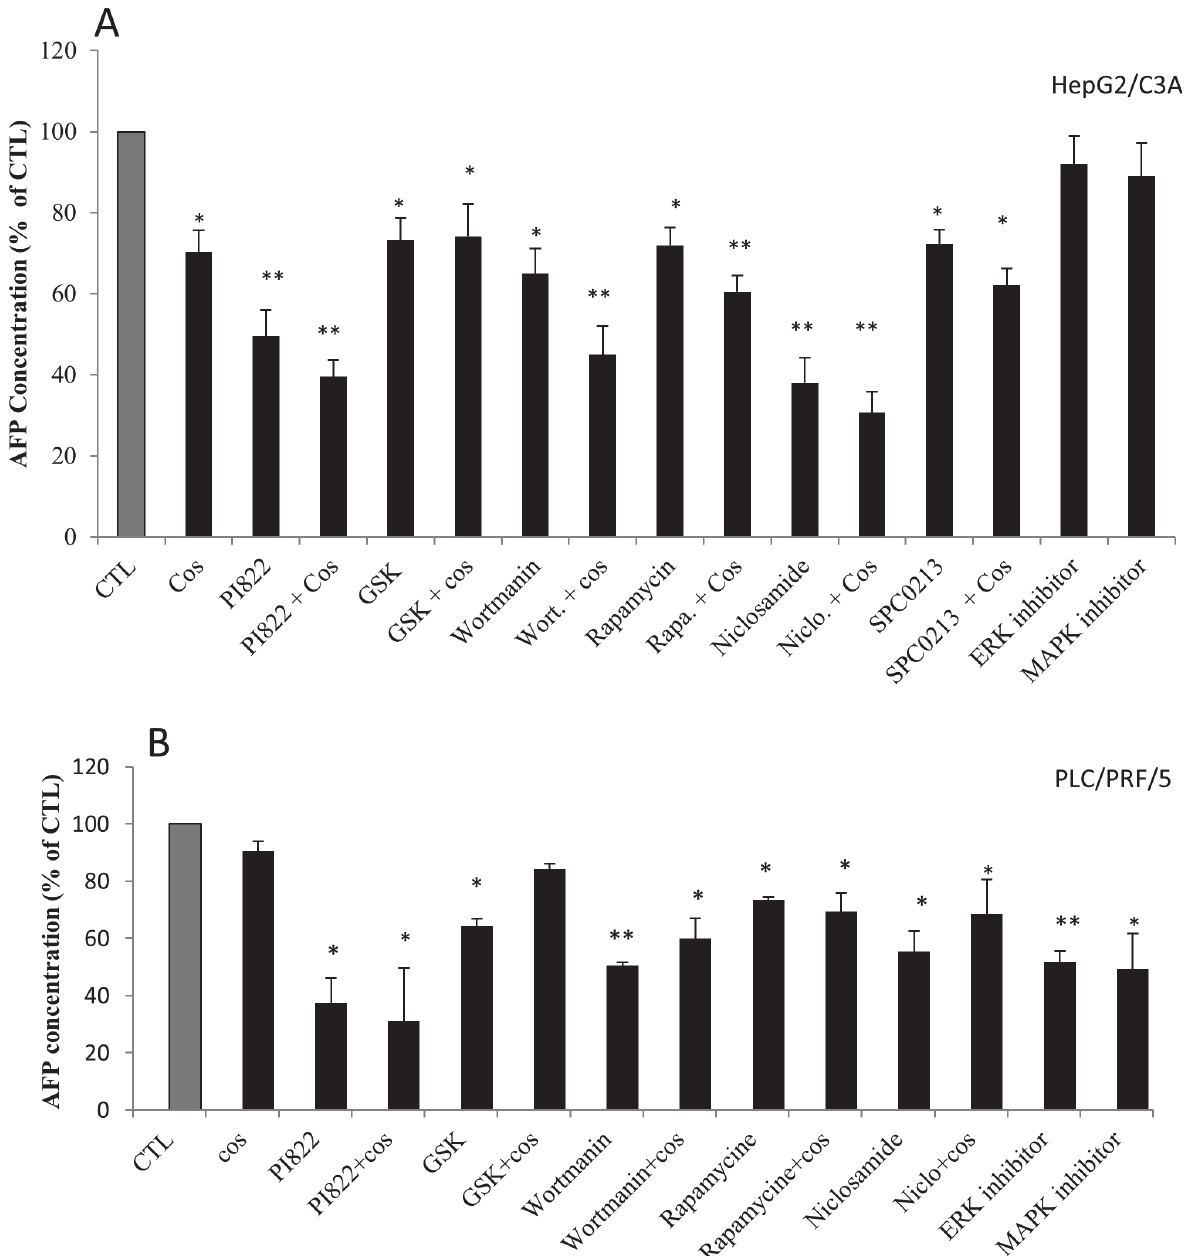
Fig 7. Effect of pathway inhibitors in the presence or absence of costunolide on AFP expression and secretion. The cells were seeded in a six-well plate at a density of 2x10 5 cells/well. At 80% confluence, the cells were treated with inhibitors of the PI3k/mTOR/Akt and MAPK/ERK signaling pathways and costunolide for 48 h. The supernatants were then collected and assessed by ELISA. (A) Effect of inhibitors of the PI3K/Akt/mTOR pathway on AFP secretion by HepG2/C3A cells. (B) Effect of inhibitors of the PI3K/Akt/mTOR pathway on AFP secretion by PLC/PRF/5 cells. * P < 0.05 versus untreated cells. ** P < 0.01 versus untreated